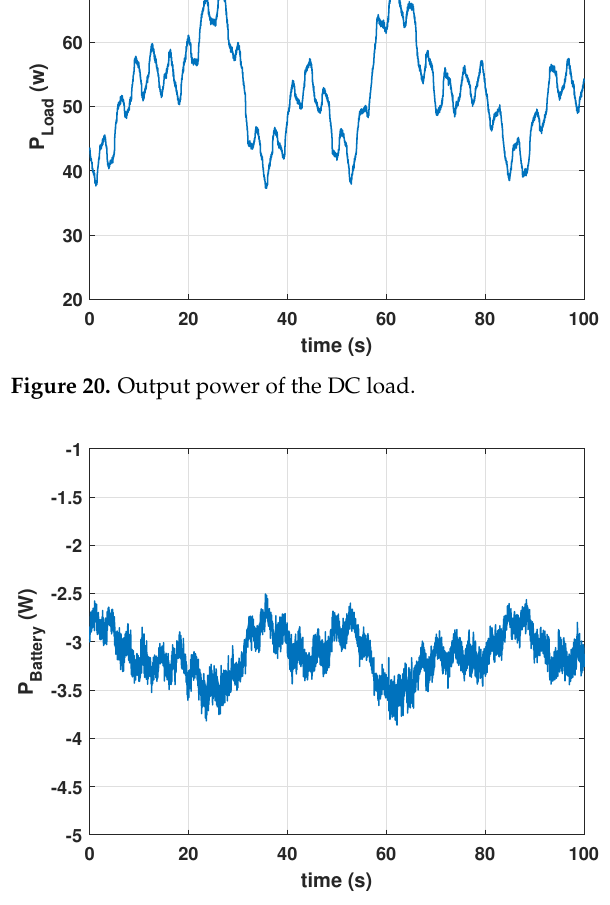
Figure 21. Power of the battery